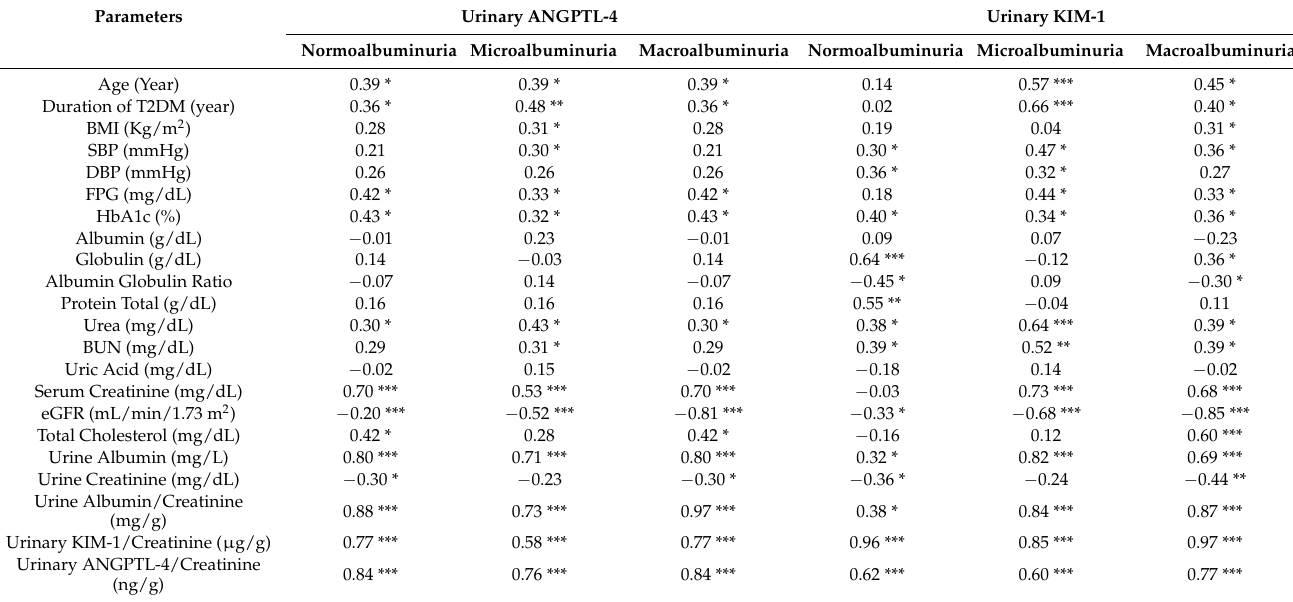
Table 2. Spearman rank correlation ofANGPTL-4 (pg/mL) and urinary KIM-1 (ng/mL) with different parameters of the